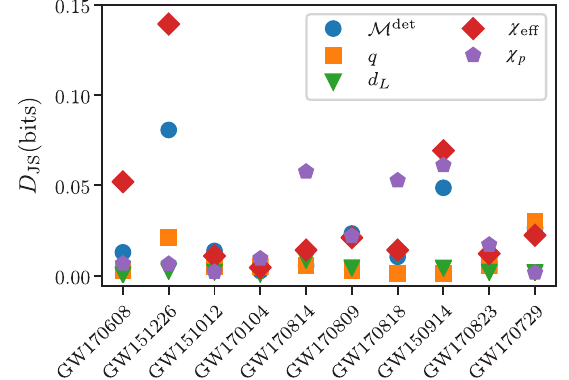
FIG. 16. Jensen-Shannon divergence between the two precess- ing BBH waveform models for key binary parameters, detector- frame chirp mass, mass ratio, luminosity distance, effective aligned spin, and effective precession